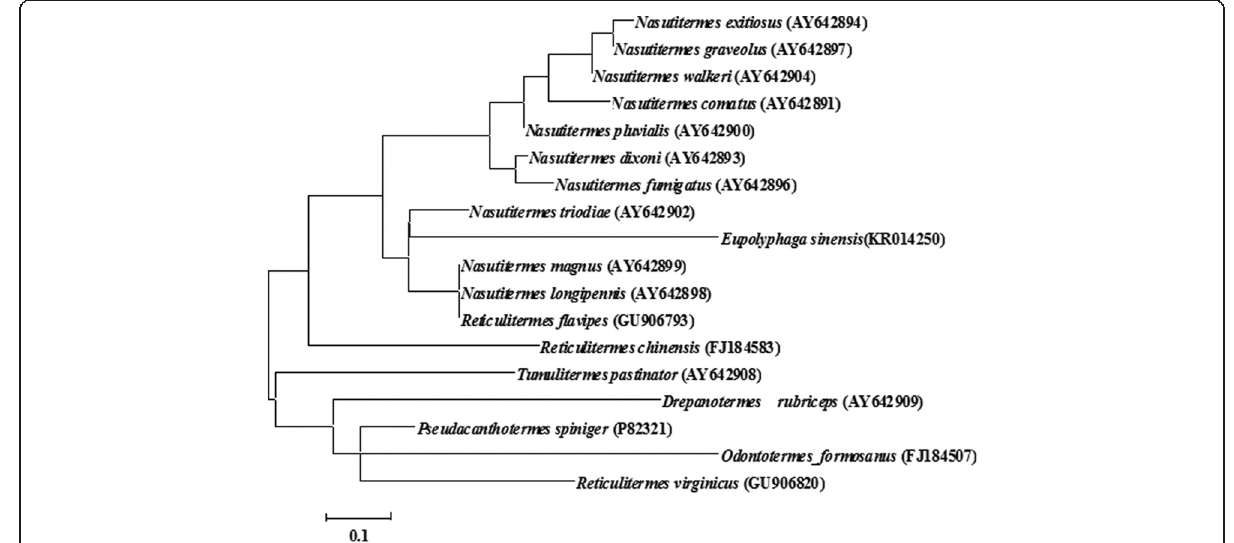
Fig. 4 Phylogenetic tree of termicins. A distance tree (maximum-likelihood) for mature termicins was constructed by MEGA 6. The species name and GenBank accession number are indicated in the tree. Numbers at the nodes represent bootstrap proportions on 1000 replicates. Scale bars are in nucleotide substitutions per site